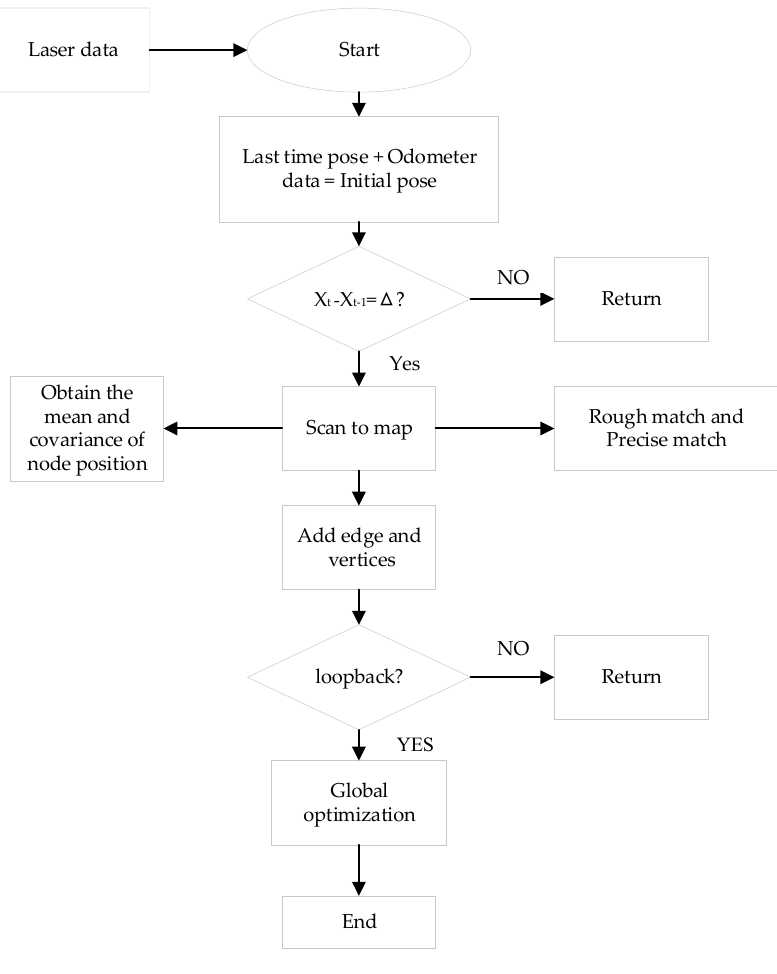
Figure 6. Karto SLAM Flowchart.